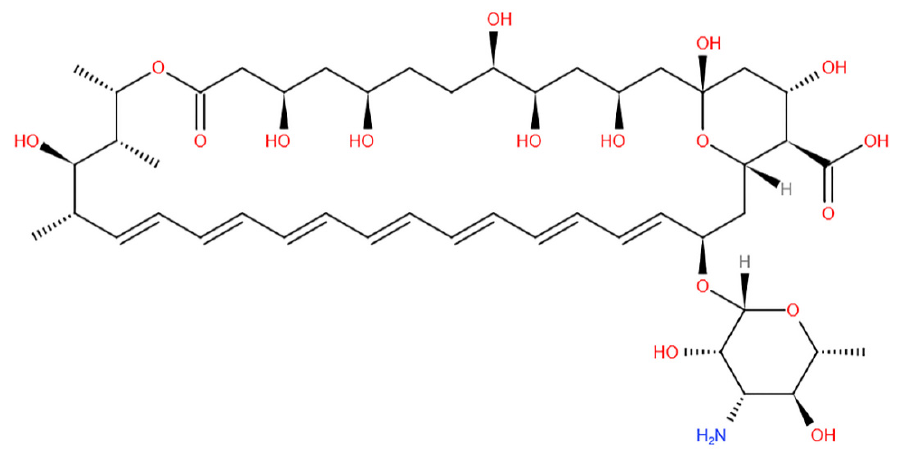
Figure 6. Chemical structure representing Amphotericin B.